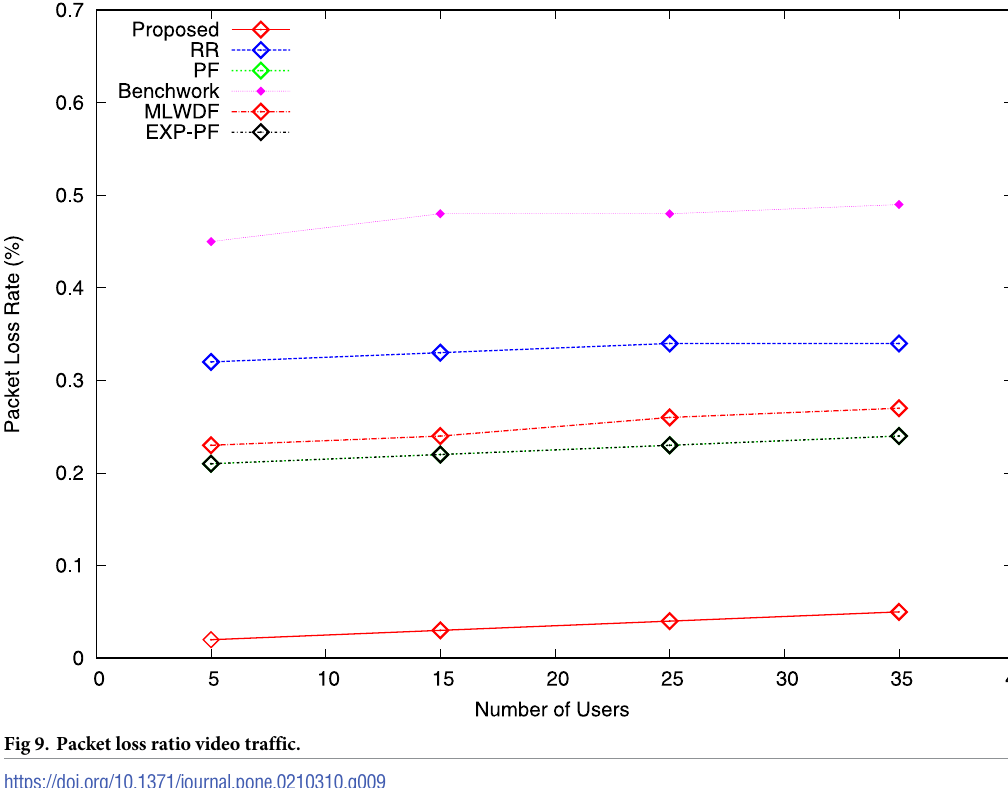
Fig 9. Packet loss ratio video traffic.